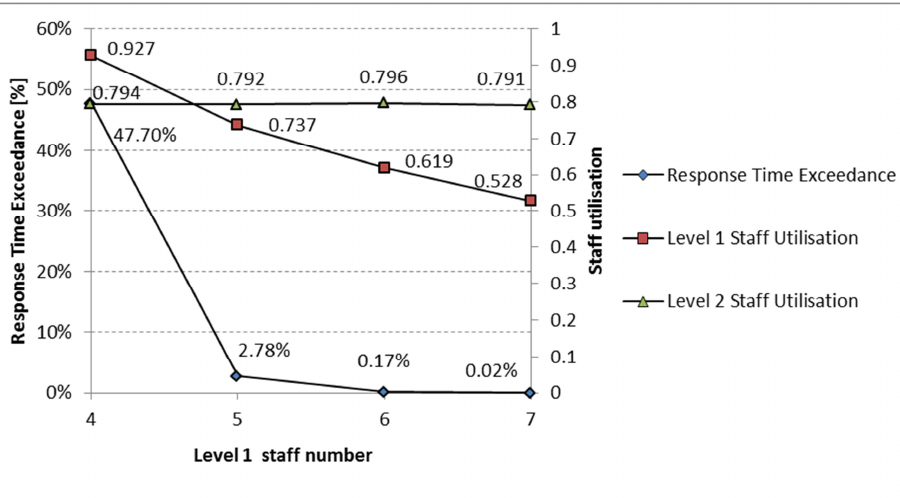
Figure 3 – Response time exceedance and staff utilisation vs. staff